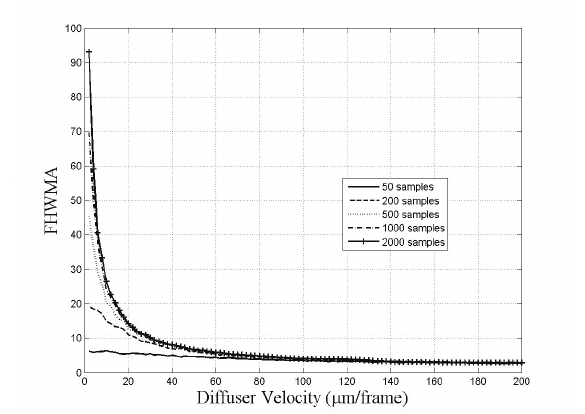
Fig.4: Full Width Half Maximum of the Autocorrelation ( FHWMA )